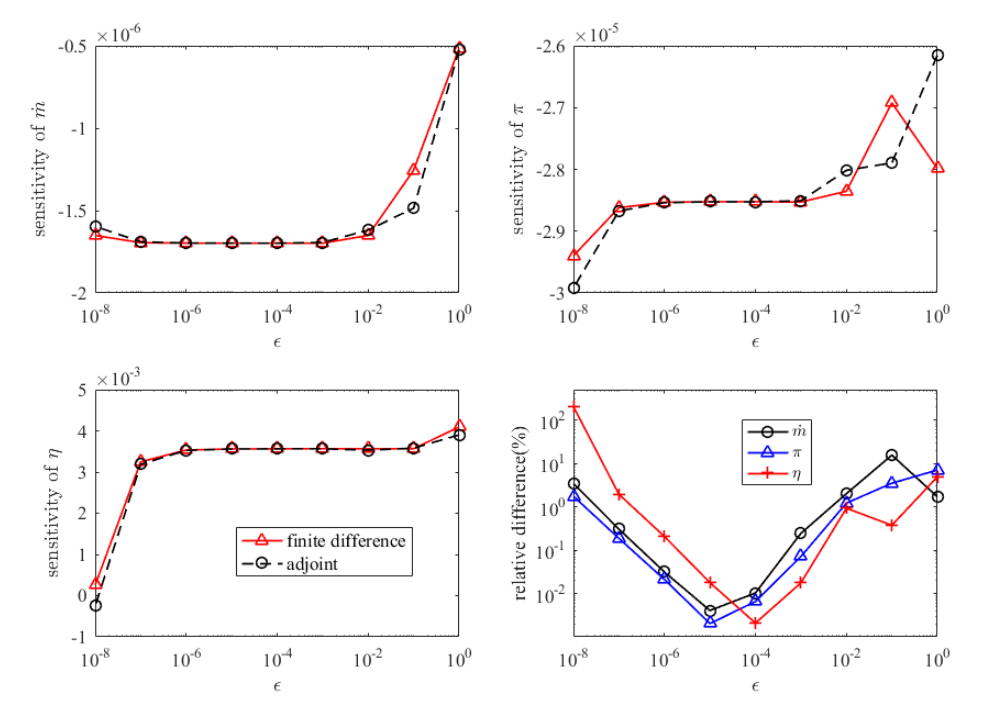
Figure 8. Comparison of sensitivities between the finite difference and the adjoint